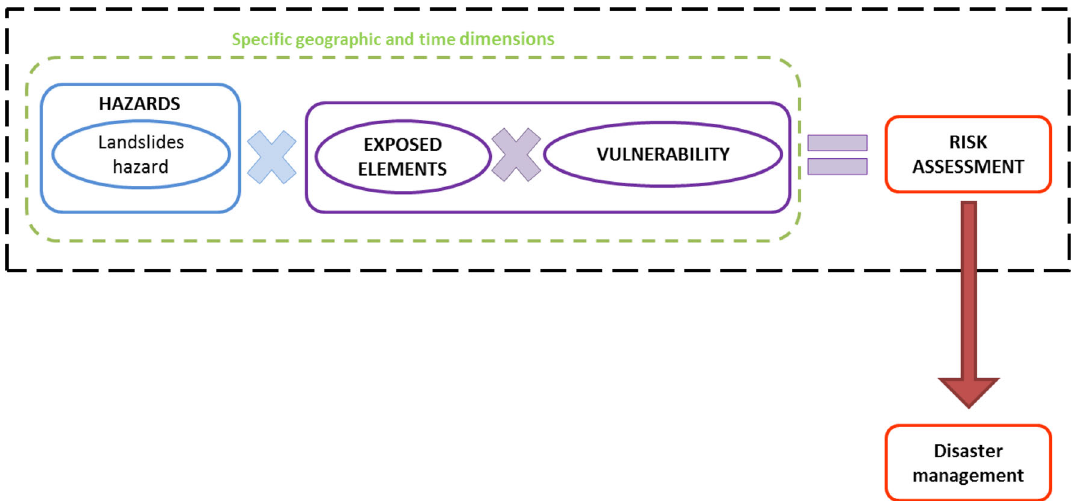
Fig. 9 Conceptual model used in the GeoRisCA project, based on Wisner et al.